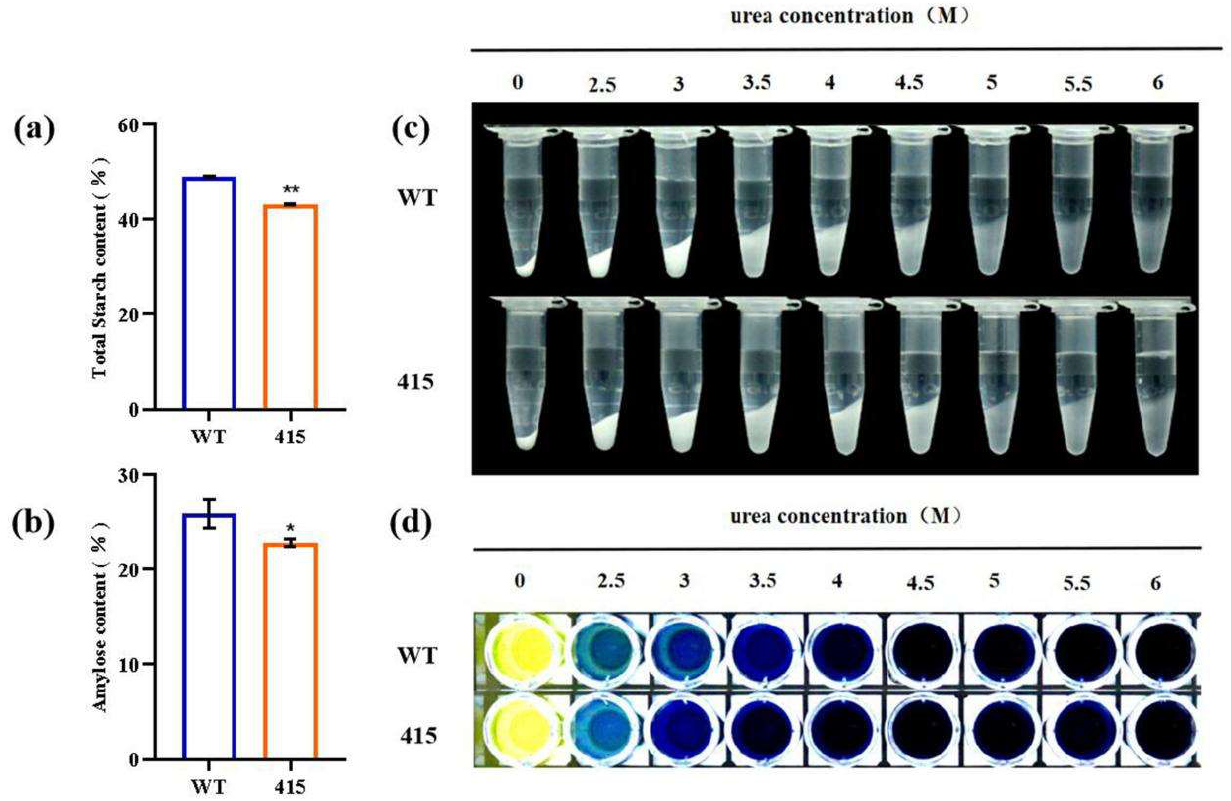
Figure 4. Starch parameters and characteristics of starch gelatinization in urea solution for the parental WT and mutant M3-415 lines. ( a , b ) Total starch and amylose contents of the WT and M3-415 lines. Values are expressed as means ± SD ( n = 3). Asterisks indicate statistical significance between the lines as determined using the Student’s t -test (* p < 0.05; ** p < 0.01). ( c , d ) Starch in WT and M3-415 grains was difficult to gelatinize in urea solution. The starch powder was mixed with different concentrations (0–6 M) of urea solution, and distilled water was used a blank control.